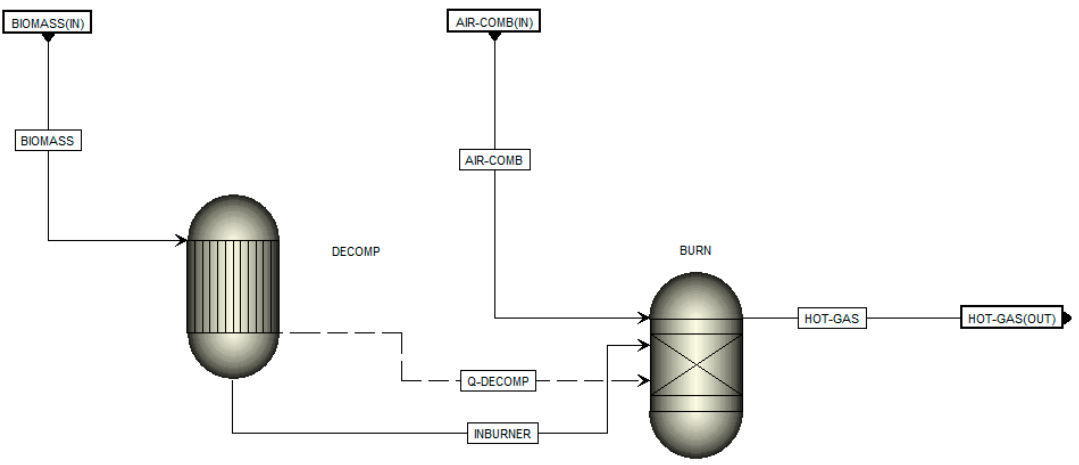
Figure 12. Flowsheet of Hierarchy block.